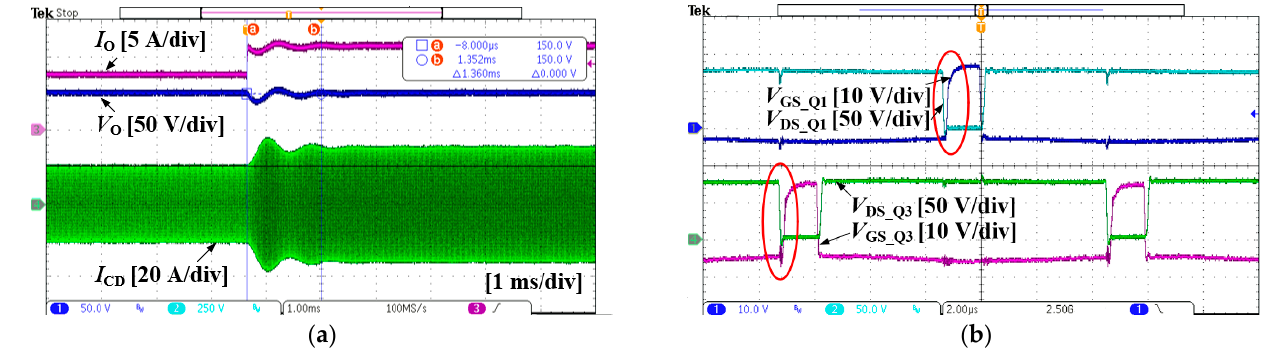
Figure 9. Measured waveforms: ( a ) transient response and ( b ) soft-switching.